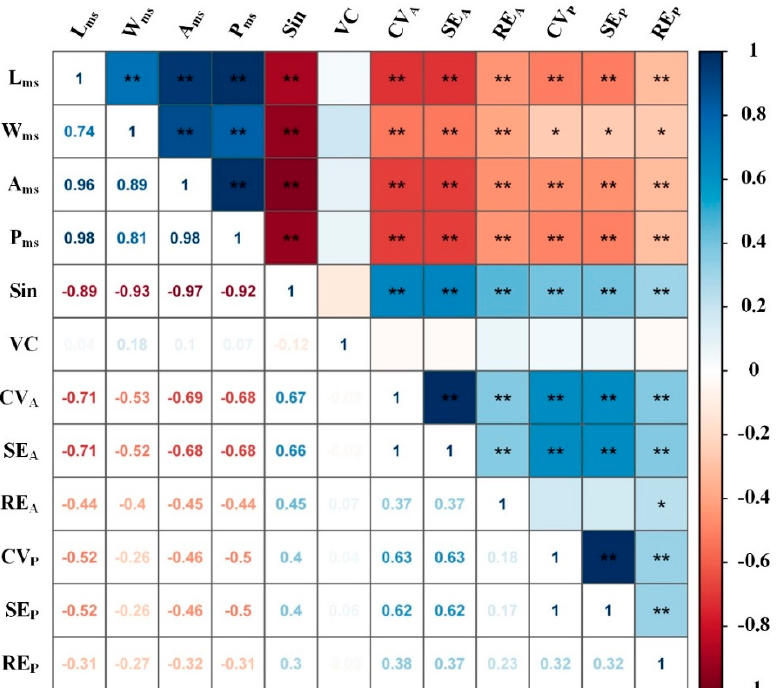
Figure 4. Correlation matrix between gully interpreting errors and potential influencing factors. Note: L ms , measured gully length; W ms , measured gully width; A ms , measured gully area; P ms , measured gully perimeter; Sin , sinuosity of gully edge line; VC , vegetation cover; CV A , coefficient of variance of interpreted gully area replications; SE A , systematic error of interpreted gully area replications; RE A , relative error between the interpreted and the measured gully area; CV P , coefficient of variance of interpreted gully perimeter replications; SE P , systematic error of interpreted gully perimeter replications; RE P , relative error between the interpreted and the measured gully perimeter. *